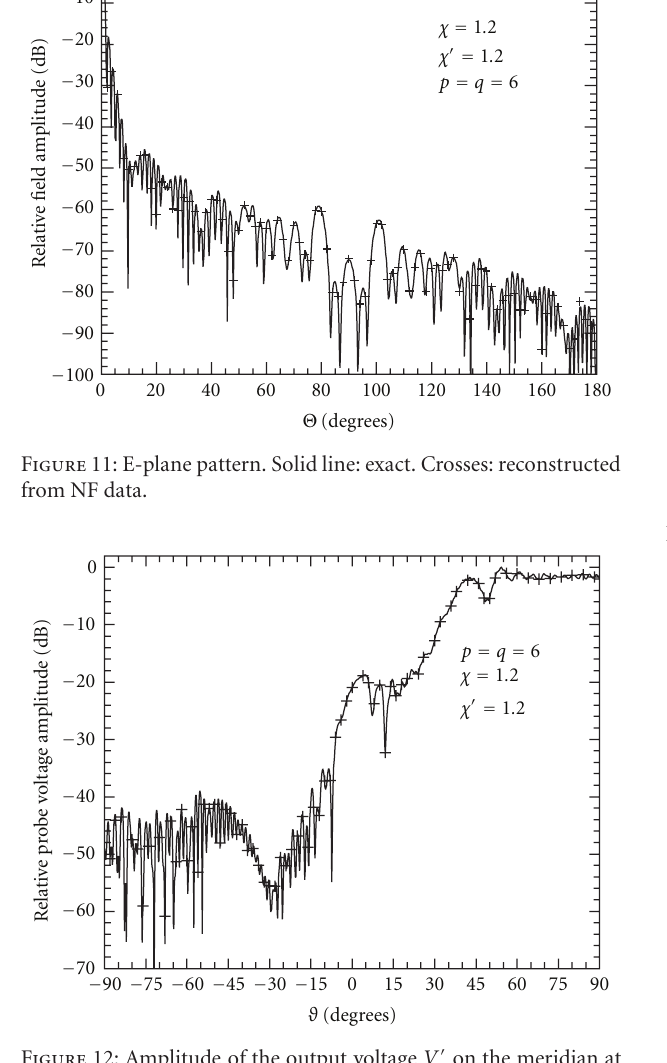
Figure 12: Amplitude of the output voltage V (cid:2) on the meridian at ϕ = 90 ◦ . Solid line: exact. Crosses: interpolated.